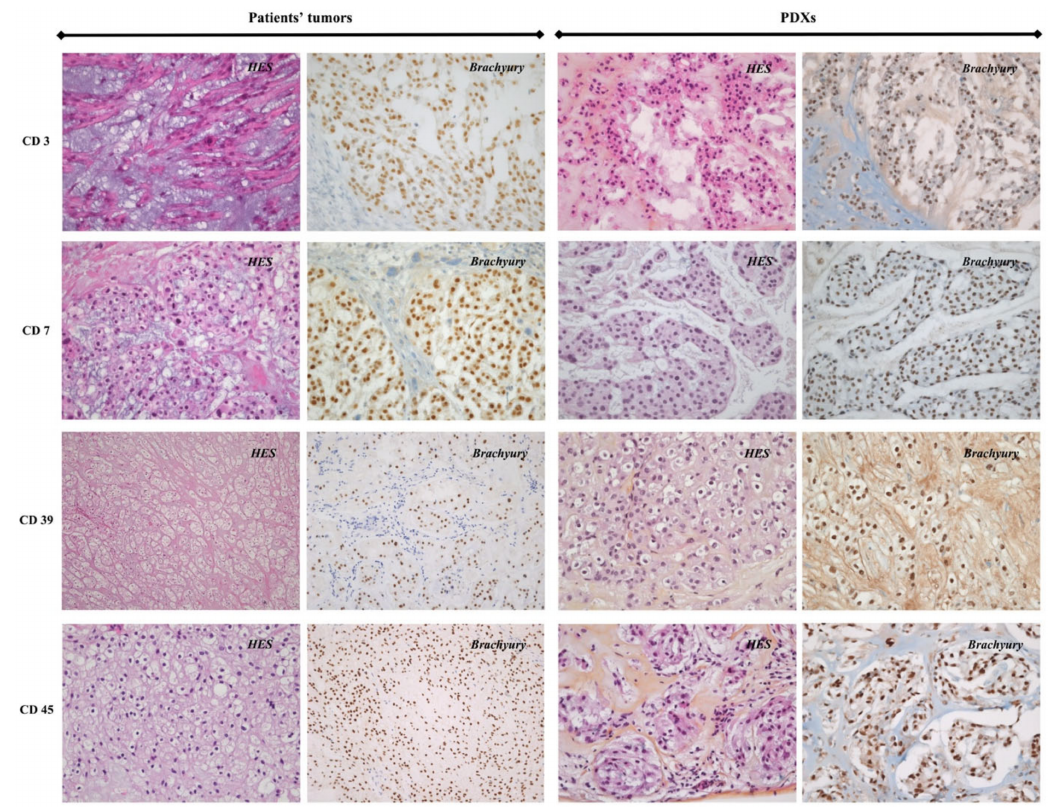
Figure 2. Histological and immunohistochemical comparison between primary patients’ tumors and their corresponding xenografts (CD3, CD7, CD39 and CD45 models). Histological analyses with HES showed that xenografts resembled the primary tumors from which they derived. All primary patients’ tumors and their corresponding xenografts were immunolabeled with brachyury (magnification × 400).